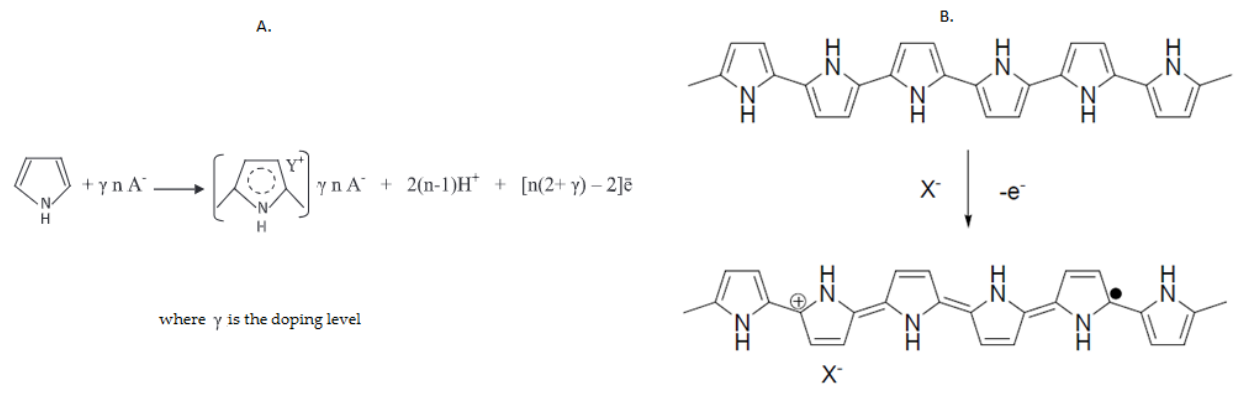
Figure 3. ( A ) General reaction of pyrrole electropolymerization (Reprinted from [50] with permission of the publisher); ( B ) Molecular structure of PPy and general doping process [51].